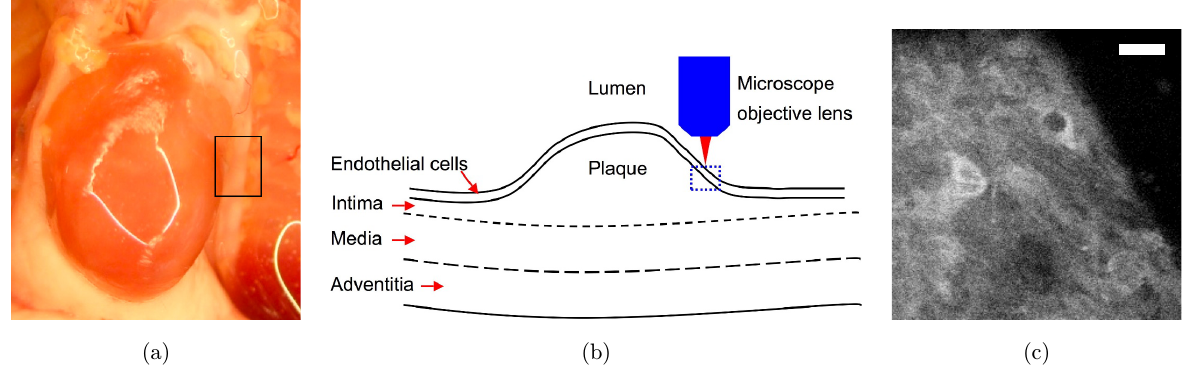
Fig. 4. Ex vivo mast cell imaging in atherosclerotic lesion (a) heart and aorta photo, (b) schematic drawing of the imaging setup and (c) mast cells in the shoulder region. (Bar: 20 (cid:4)